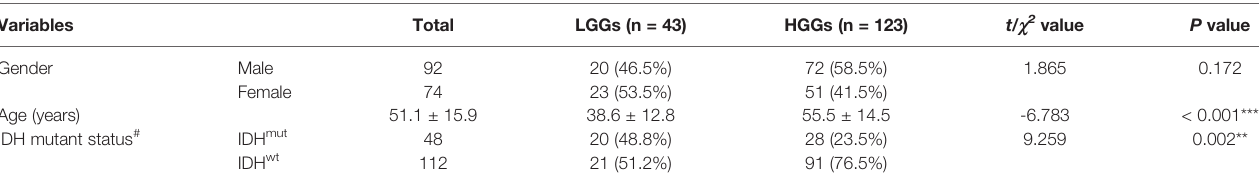
TABLE 1 | Demographics of the study